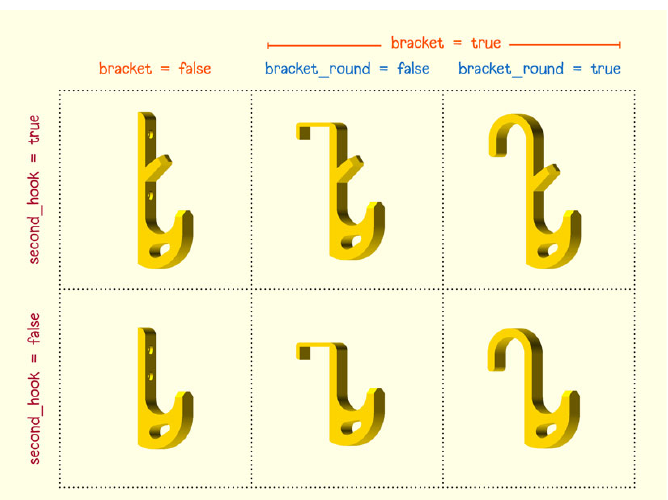
Figure 10: Different U-Hook designs with matching parameters (Payen,